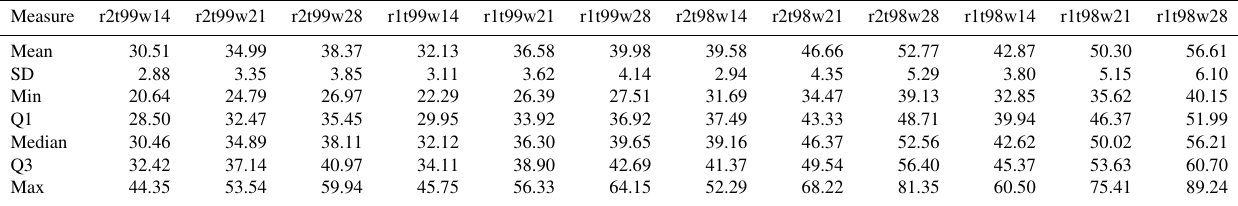
Table D1. Descriptive statistics of the S cl distributions for all parameter combinations. The measures are, from top to bottom, the mean value, the standard deviation, the minimum value, the first quartile, the median value, the third quartile and the maximum value.